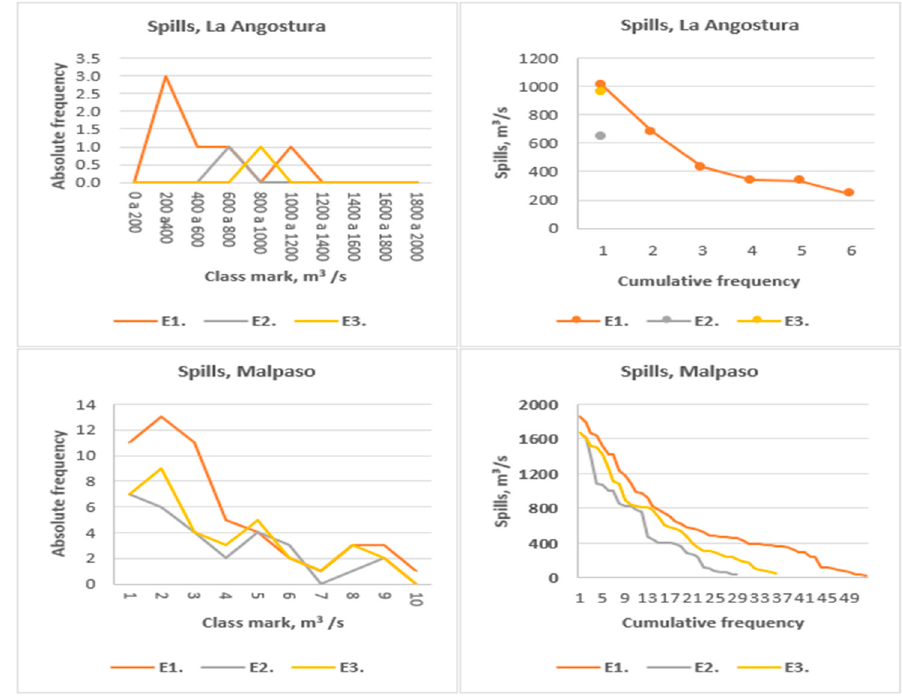
Figure 9. Spill count in the policies tested for La Angostura dam and Malpaso dam.